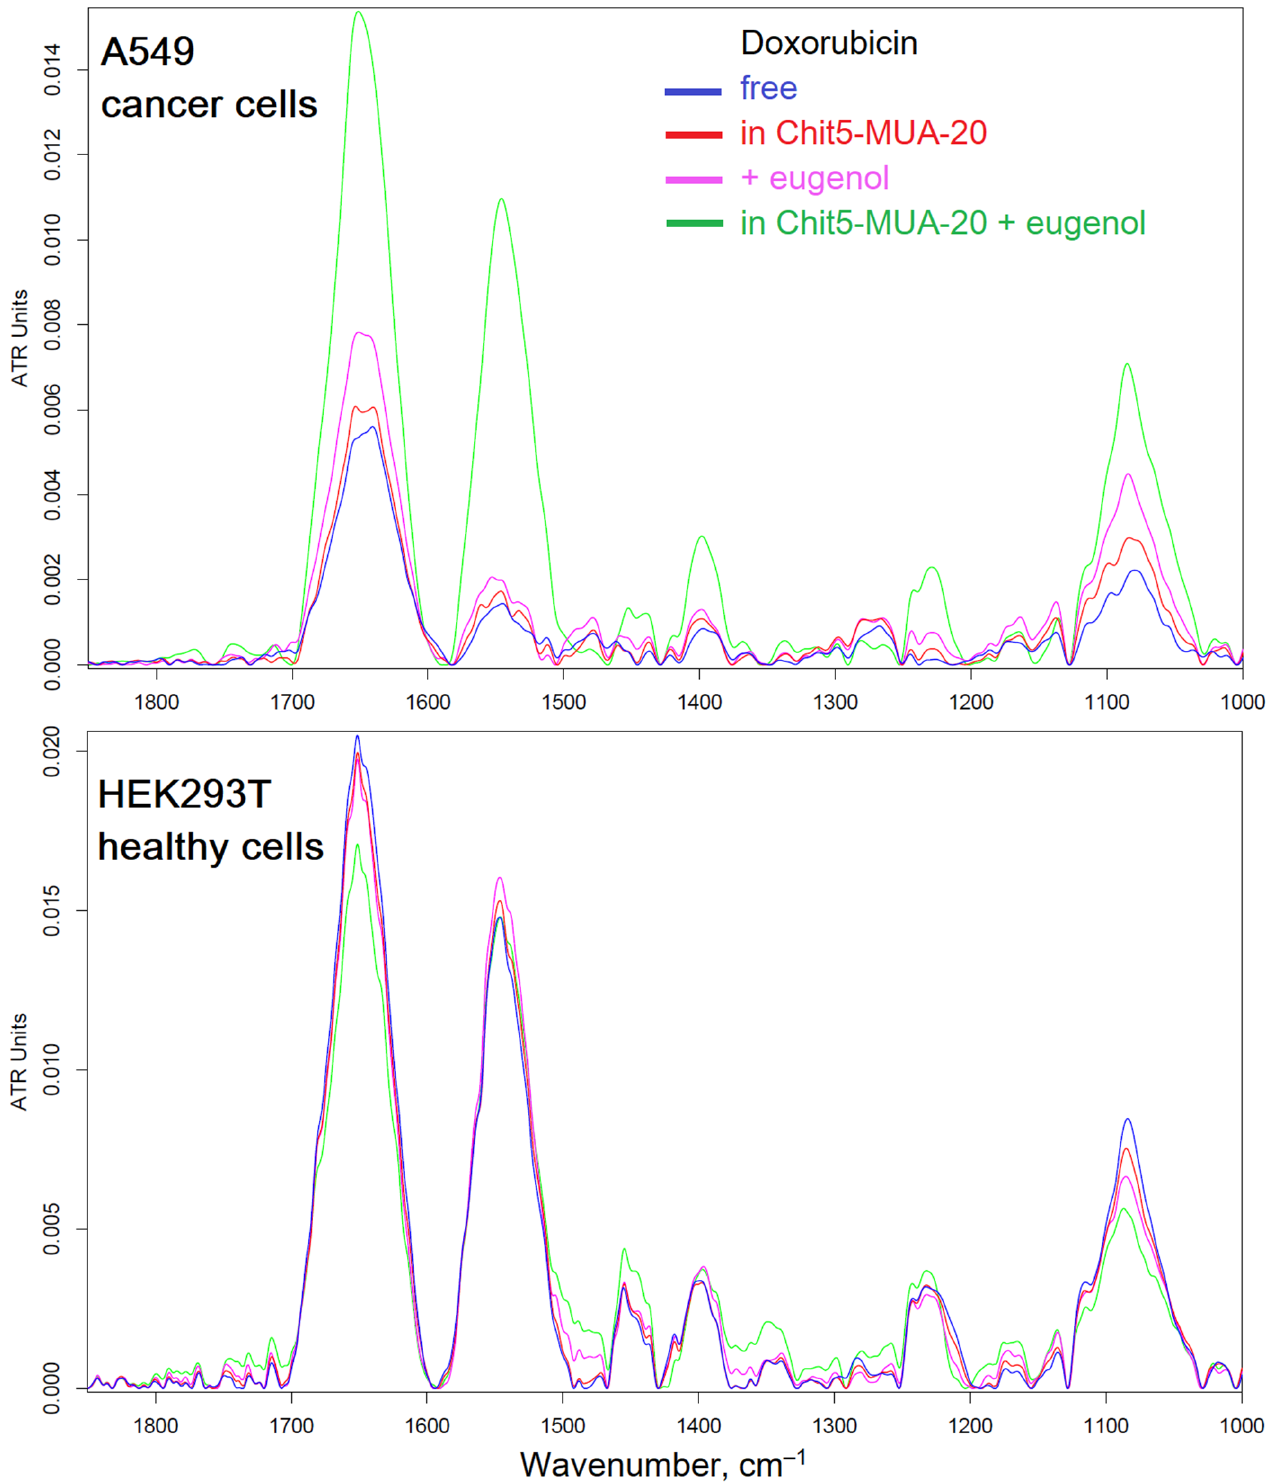
Figure 8. Difference FTIR spectra of cancer A549 cells and healthy HEK293T cells: after and before incubation for 3 h with doxorubicin (0.1 mg/mL). Free Dox, Dox + EG (0.1 mg/mL), or Dox in micellar form (polymer:Dox = 1:2 w / w ) were used. pH = 7.4 (PBS, 0.01 M). T = 37 °C.